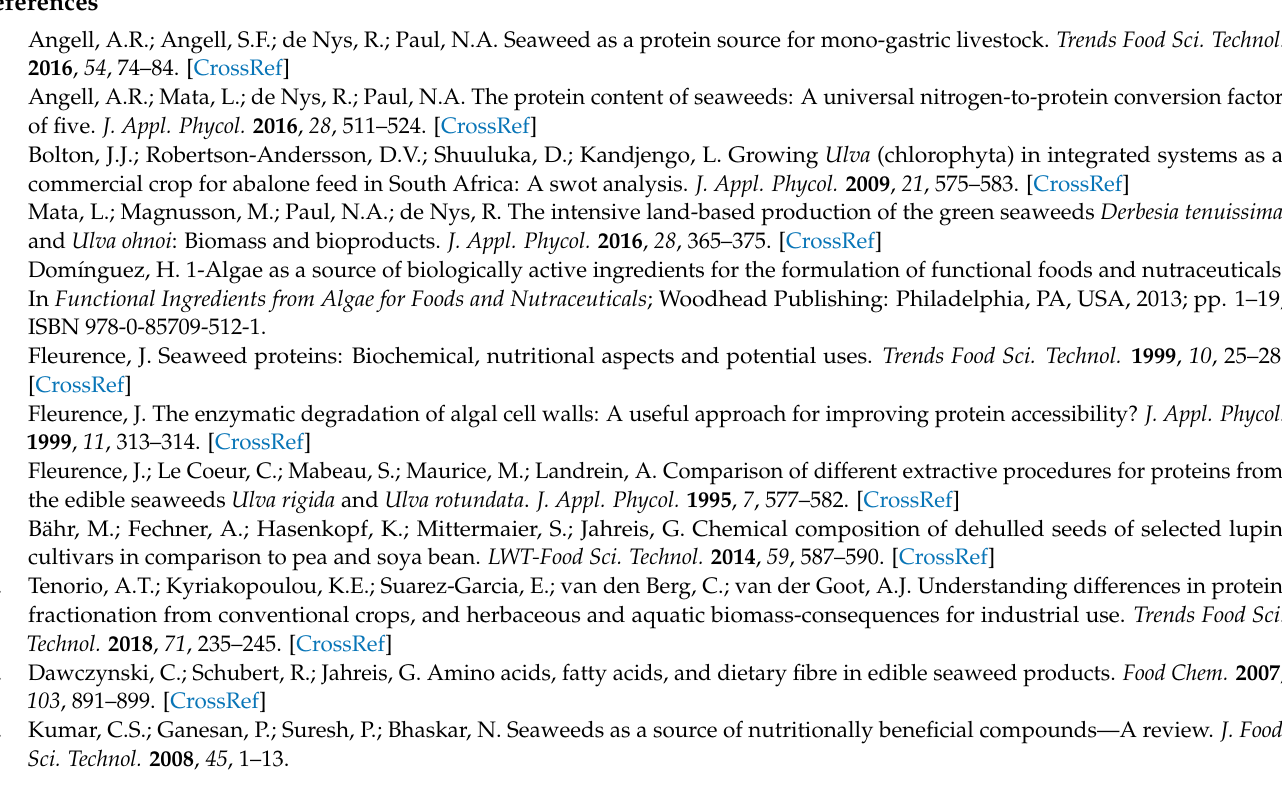
micro (Fe) elements as well as trace metals of beach-cast macroalgae. Values represent the average of three technical replicates (mean ± SD), and letters indicate the statistical significance ( p < 0.05). Figure S3. Free amino acids composition of beach-cast macroalgae. Values represent the average of three replicates (mean ± SD), and letters indicate the statistical significance ( p < 0.05). Figure S4. Fatty acids composition of beach-cast macroalgae. Values represent the average of three replicates (mean ± SD), and letters indicate the statistical significance (p < 0.05). Statistical analysis was con- ducted only for amounts over 10. Figure S5. Solubility of total proteins from beach-cast macroalgae at different pH levels. Values represent the average of three replicates (mean ± SD), and letters indicate the statistical significance ( p <